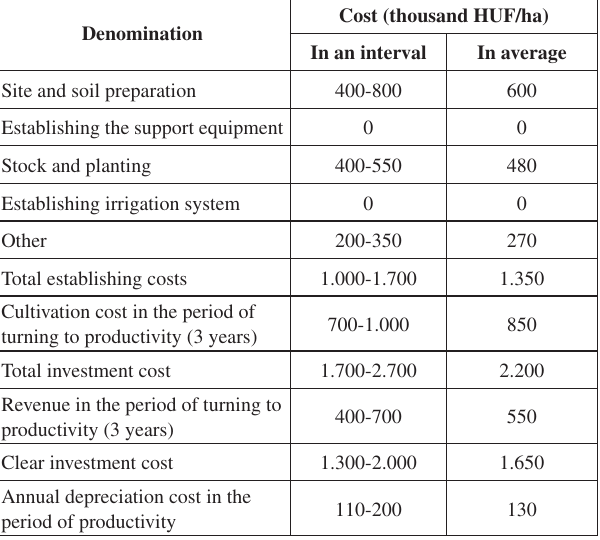
Table 1: The Investment Cost of the Characterized Elderberry